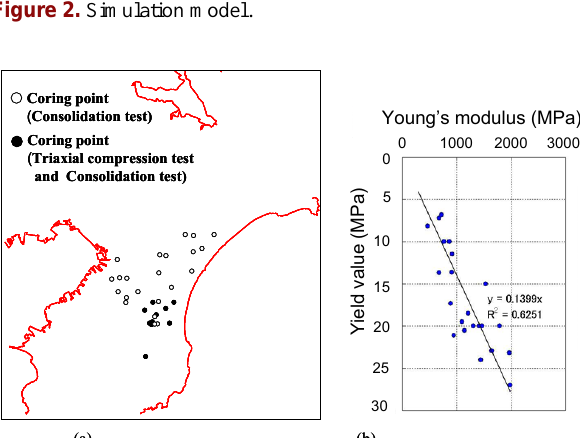
Umegase.F Ohara.FKiwada.FOtadai.F